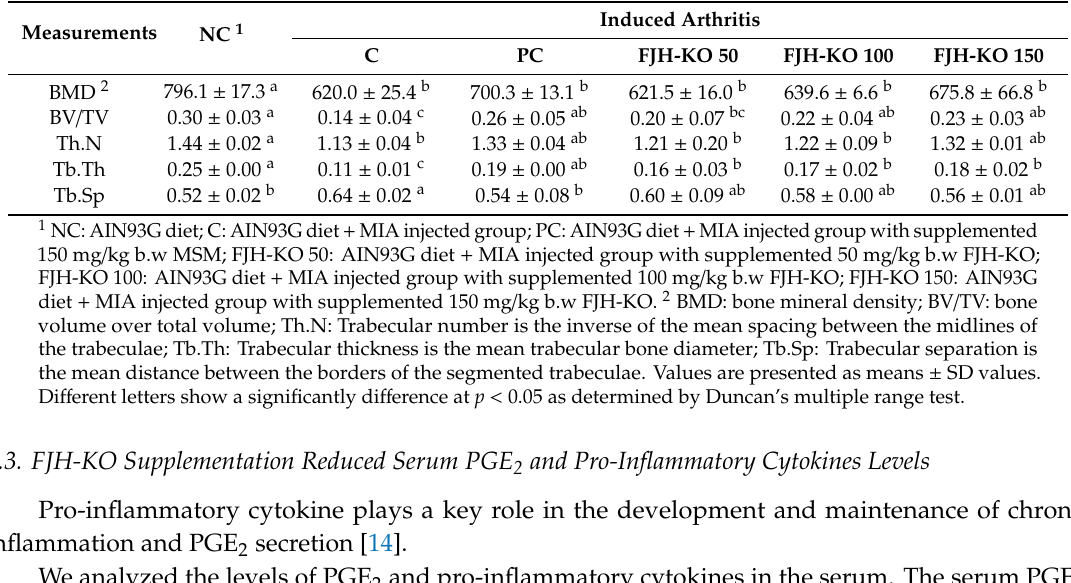
Table 2. Morphological parameters of cortical bone.